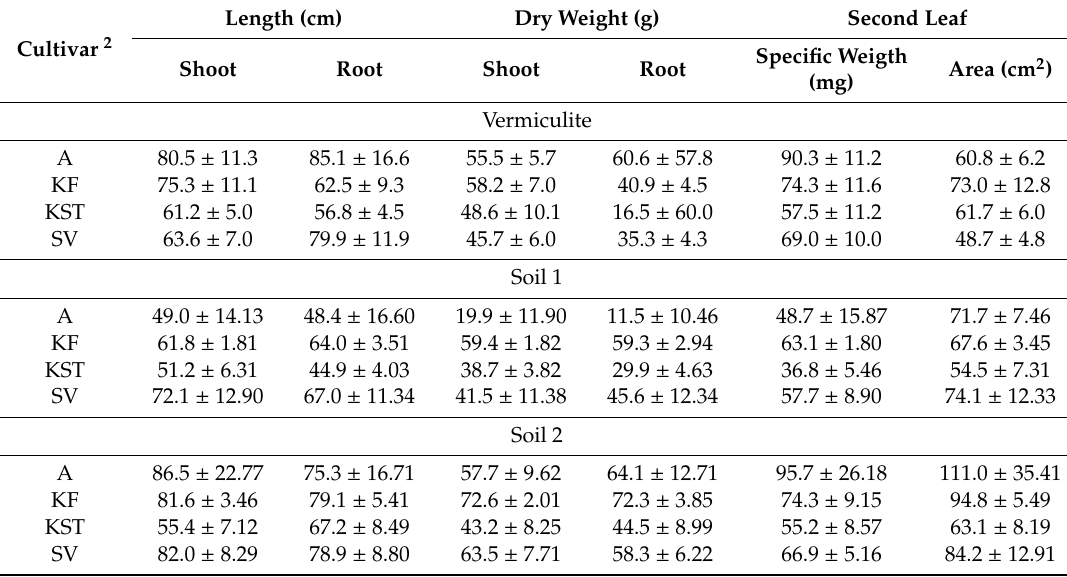
Table 3. E ff ective doses causing 50% of inhibition (ED50) values ( ± standard error) 1 for the maize cultivars growing in the three di ff erent growth substrates amended with five doses of microencapsulated peppermint